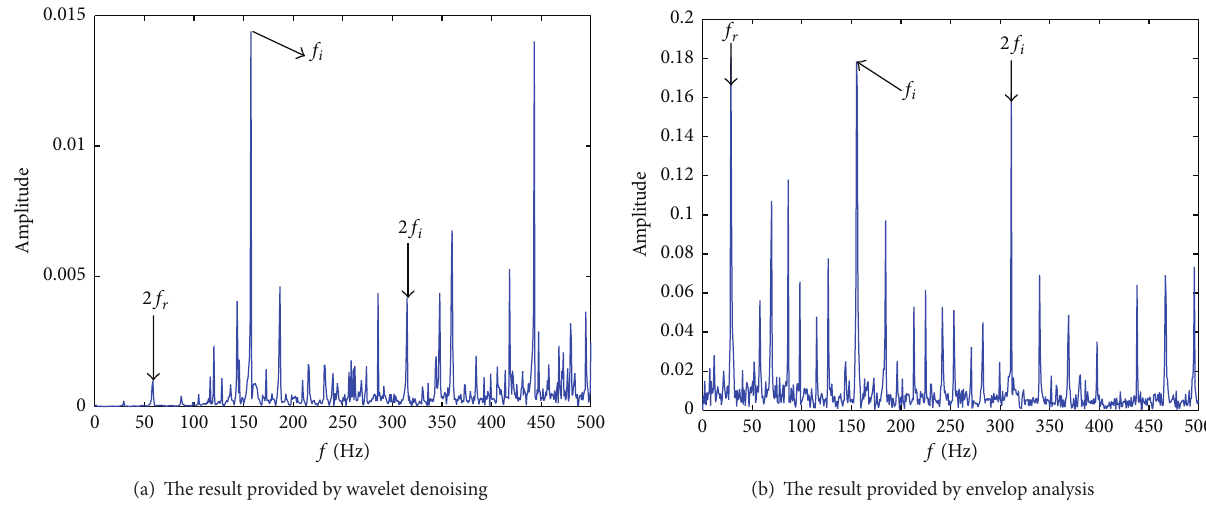
Figure 6: The result with wavelet denoising method.